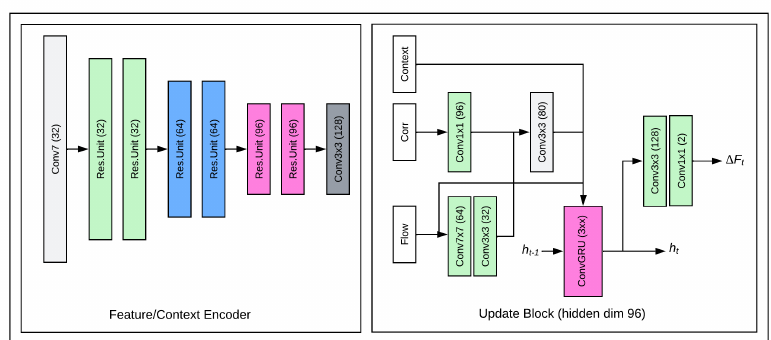
Figure 12. The model was used in this study [33].